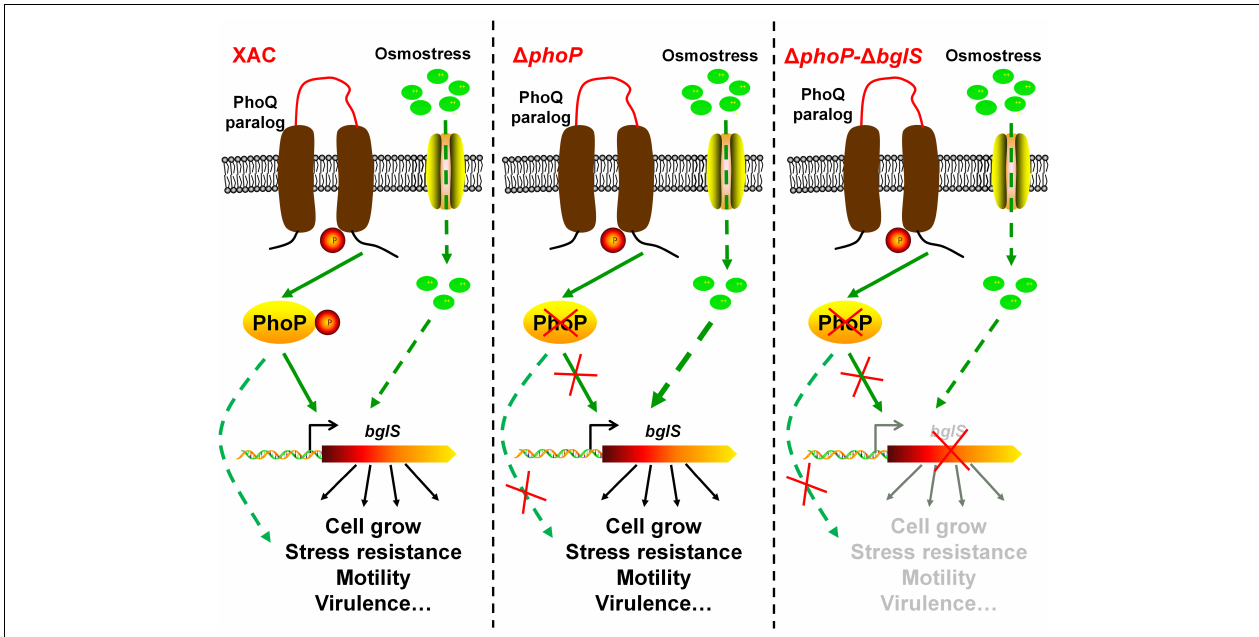
FIGURE 8 | Model of speculation about PhoP and low osmostress regulation mechanism. The proposed regulatory pathways of PhoP and low osmostress based on our observations and previous studies. Two-component system response regulator PhoP is critical for X. citri growth and virulence. In the wild type, PhoP can directly regulate the expression of BglS. The deletion of phoP ( (cid:49) phoP ) from X. citri significantly compromised the growth and virulence as compared to the wild-type strain. Simultaneously, the expression of bglS gene was significantly down-regulated in phoP mutant. This study revealed that the physiological deficiency of phoP mutant can be reversed by low osmostress induced β -glucosidase (BglS) expression and proposes a novel regulatory mechanism of β -glucosidase activation through low osmostress to reverse the fitness deficiency in X. citri